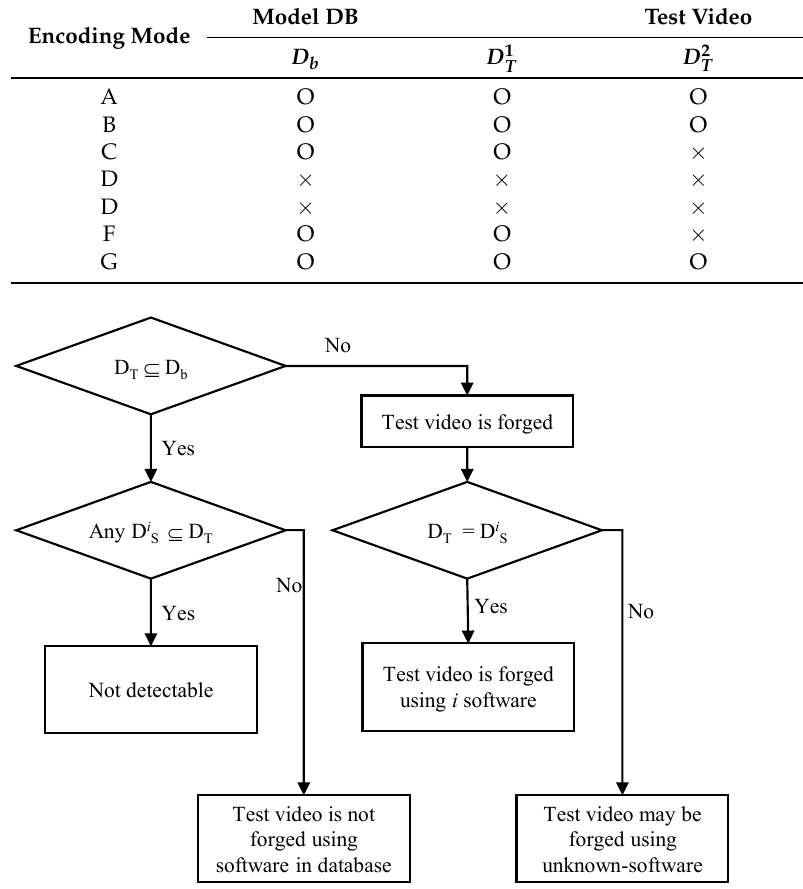
Figure 4. Proposed decision rule. D T , D b , and D i and the i software video encoder,